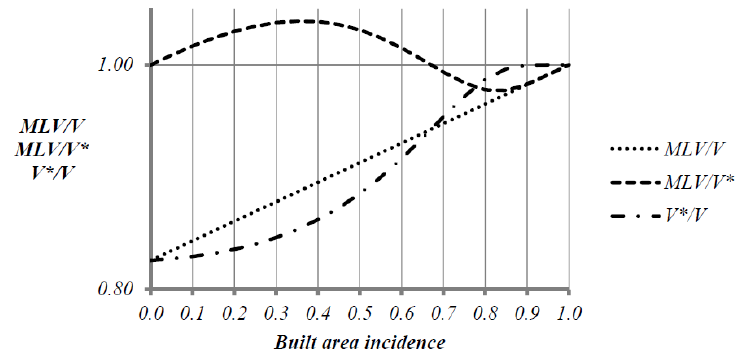
Figure 5. Relationship between MLV / V, MLV / V *, and V */ V and the built area incidence.